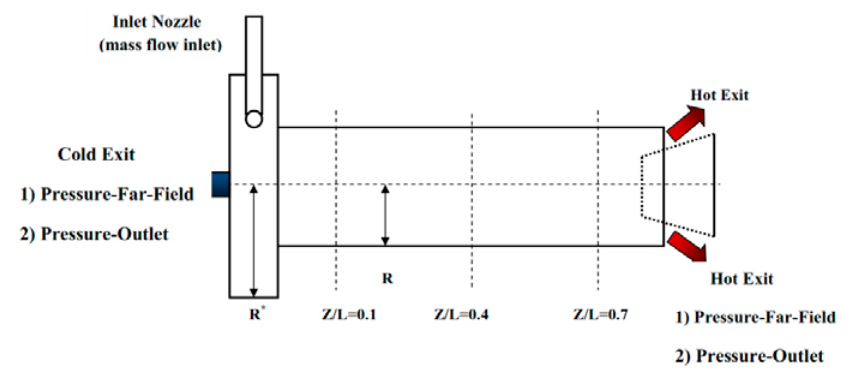
Fig. 6. Details of the boundary conditions used in the